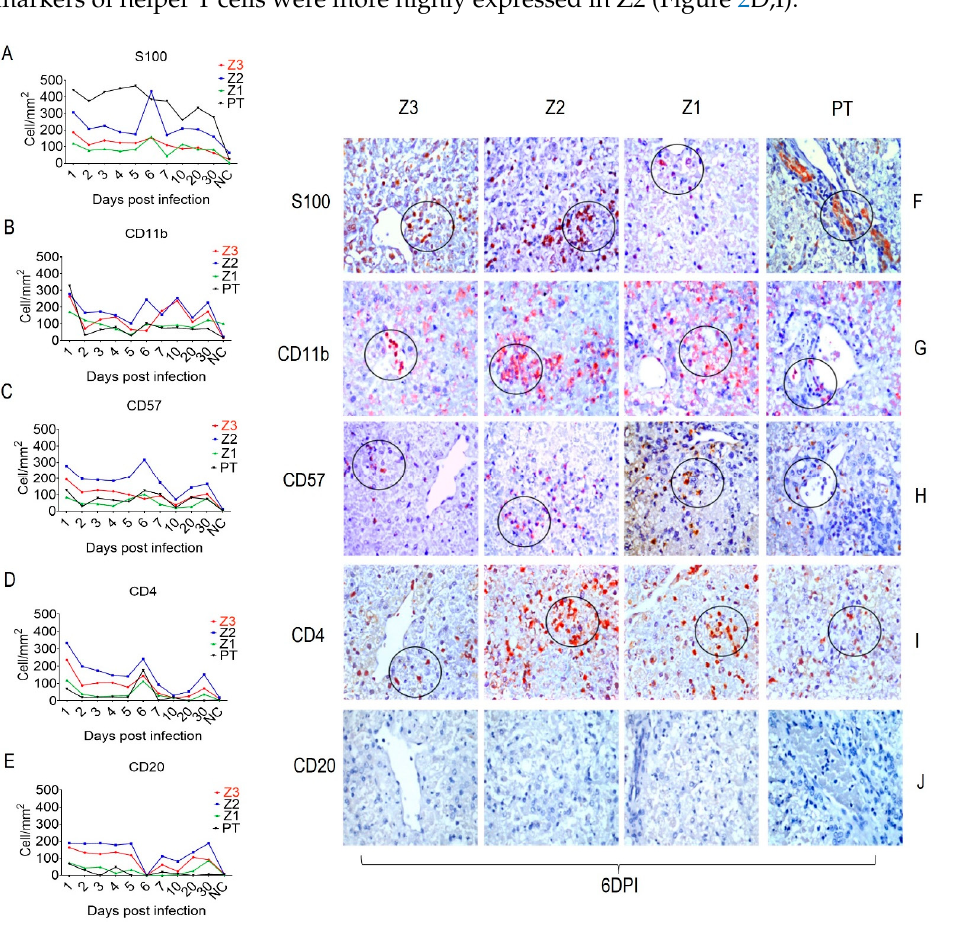
Figure 2. Quantitative immunohistochemical analysis for specific antibodies for immune cells in Z3, Z2, Z1 and PT cells in hepatic parenchyma of squirrel monkeys ( Saimiri spp.) infected with YFV. Circles represent areas expressing higher immunostaining cells in different hepatic areas. ( A ) Ex- pression of S100. ( F ) Immunostaining for S100 in Kupffer cells (F-Z3), inflammatory infiltrate (F-Z2), hepatocytes (F-Z1) and bile duct (F-PT). ( B ) Expression of CD11b. ( G ) Immunostaining for CD11b macrophages in inflammatory infiltrate (G-Z3), (G-Z2), (G-Z1), (G-PT). ( C ) Expression of CD57 NK cell. ( H ) Immunostaining for CD57 in inflammatory infiltrate in all hepatic compartments (H-Z3), (H-Z2), (H-Z1), (H-PT). ( D ) CD4 expression. ( I ) Immunostaining for CD4 T lymphocyte in the in- flammatory infiltrate in all acini areas (I-Z3), (I-Z2), (I-Z1), (I-PT). (E) Expression of CD20 (B cell). ( J ) Absence of Immunostaining for CD20 in all acini areas (J-Z3), (J-Z2), (J-Z1), (J-PT). Figure E–J ob- tained after 6 dpi.